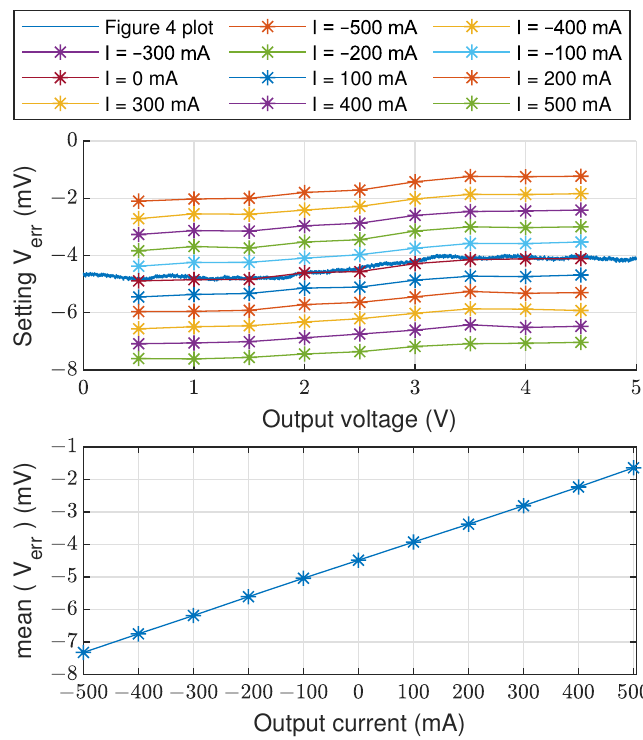
Figure 5. Characterization of the setting output voltage with different cell current values. Error as a function of the output voltage for different output currents ( top ). Mean error as a function of the output current ( bottom